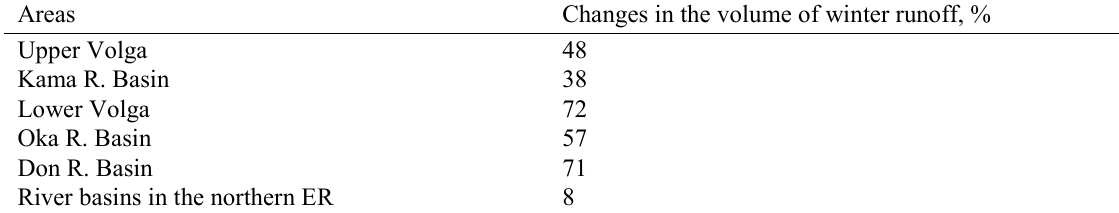
Areas Changes in the volume of winter runoff,